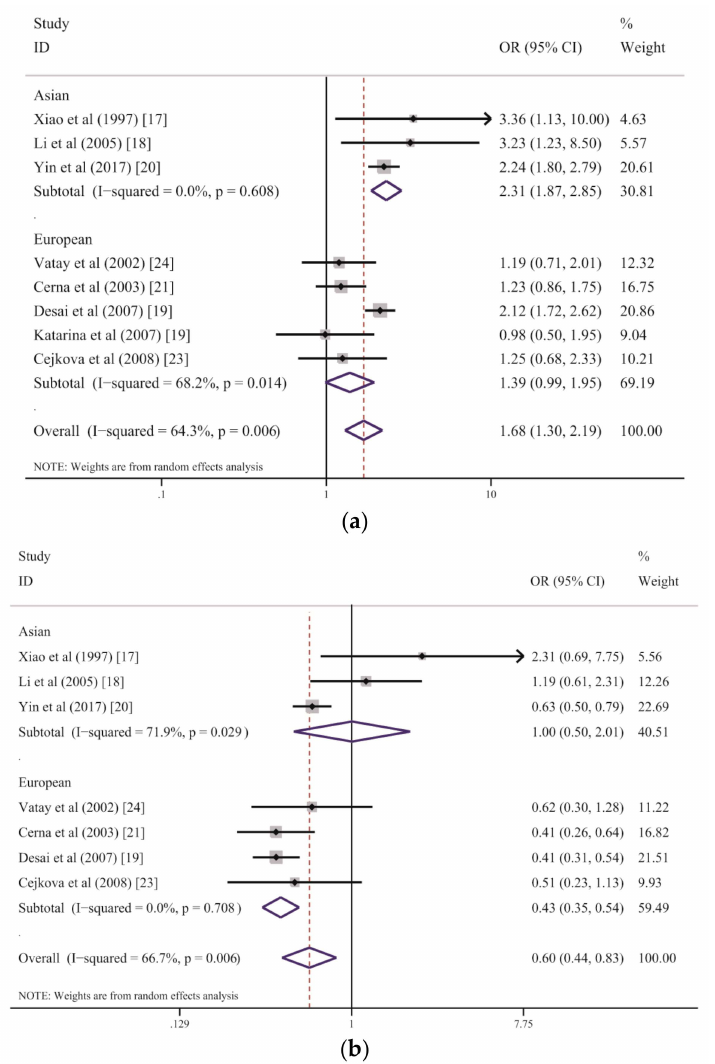
Figure 3. Forest plots of the subgroup analysis by ethnicity for correlations between HLA-DQB1*02 and HLA-DQB1*06 variants and the risk of LADA: ( a ) DQB1*02 ; ( b ) DQB1*06